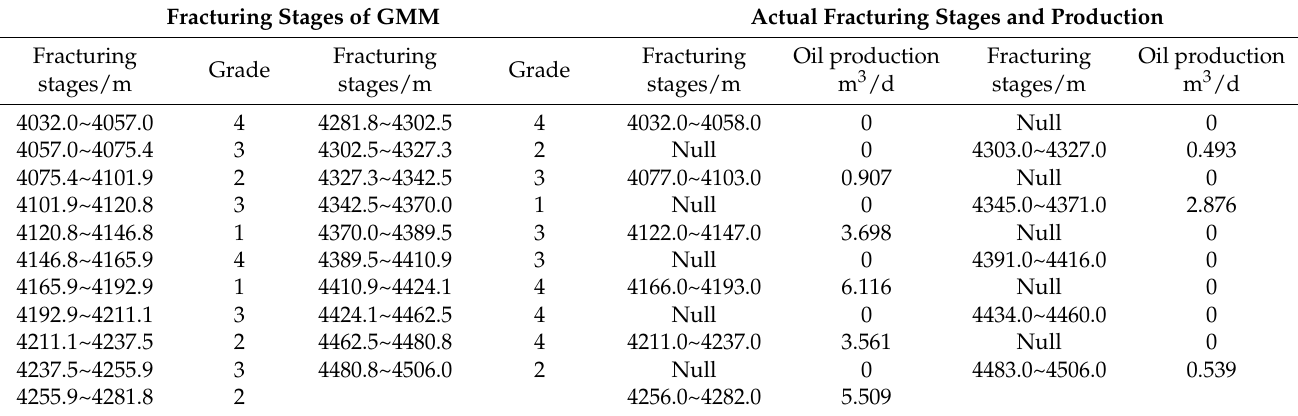
Table 4. Comparison of the prediction and actual fracturing stages in well